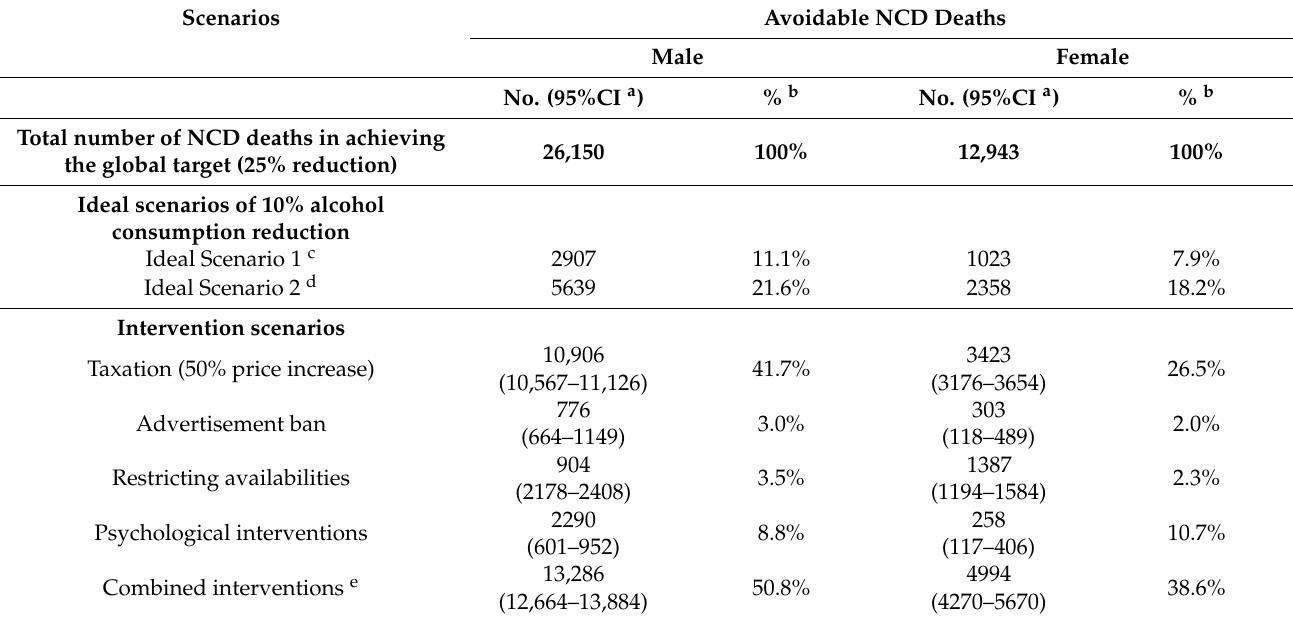
Table 1. Avoidable NCD deaths and percent in achieving the global target in 2025 of the study